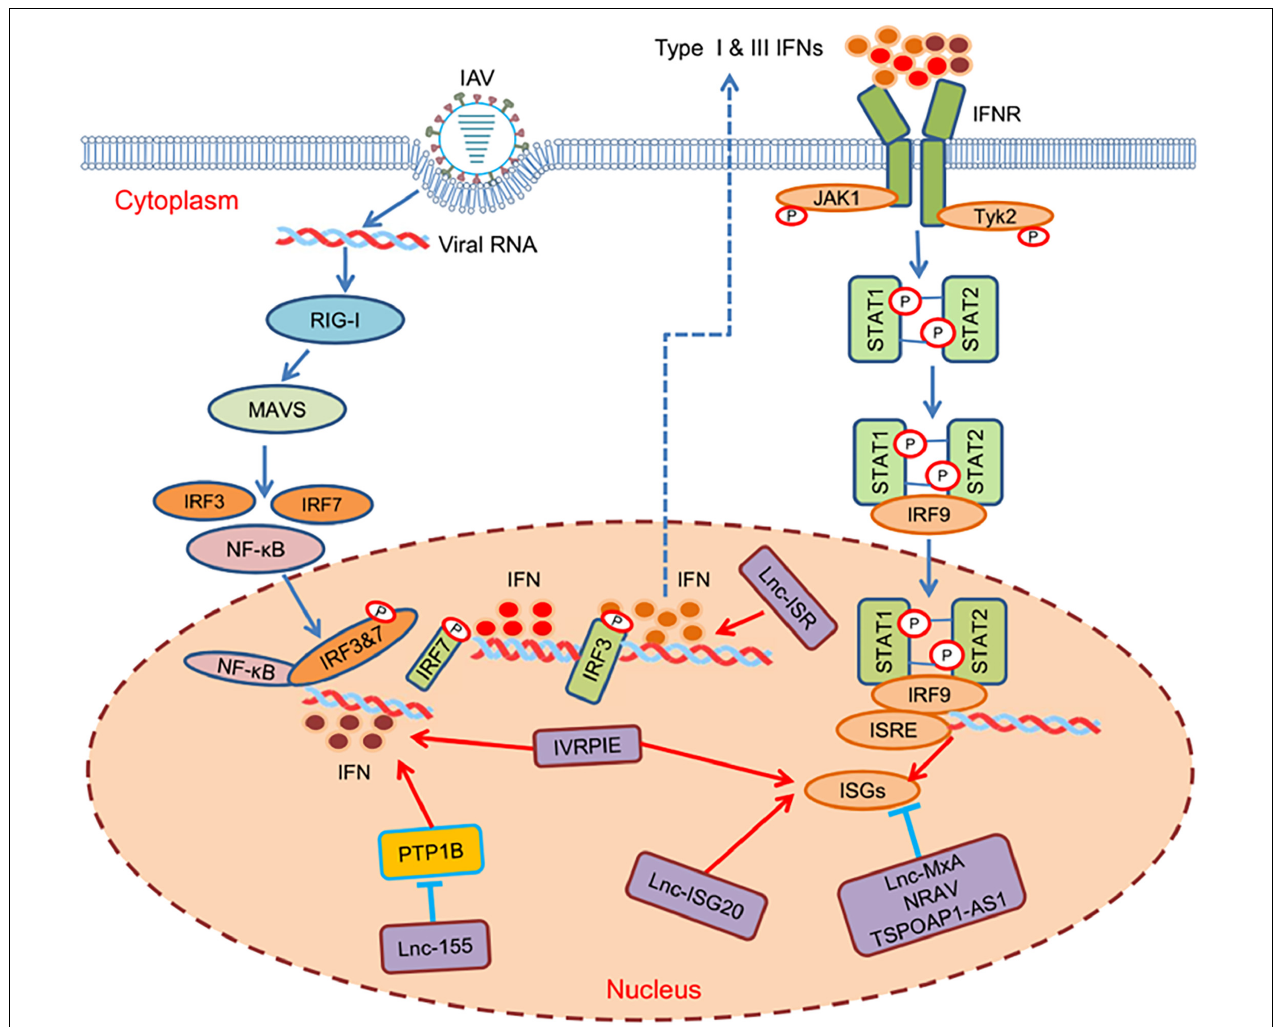
FIGURE 1 | Host lncRNAs regulate various steps of antiviral immune responses against IAV infection. Upon IAV invading host cells, the pattern recognition receptors (PRRs) signaling pathway is initiated to activate transcription factors, including NF- κ B and IRF3/7. Then, the transcription factors bind to the corresponding active sites to induce the transcription of IFNs, which activates auto- or paracrine pathways to initiate ISGs to defend viral infection through JAK-STAT pathways. Many lncRNAs are involved in the cascades to regulate different steps of the signaling pathway to inhibit or promote IAV